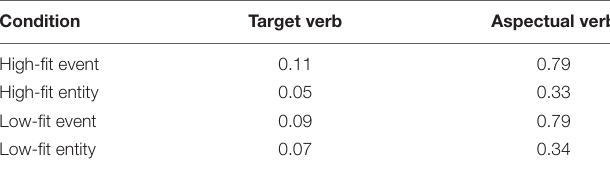
TABLE 2 | Proportions from the completion